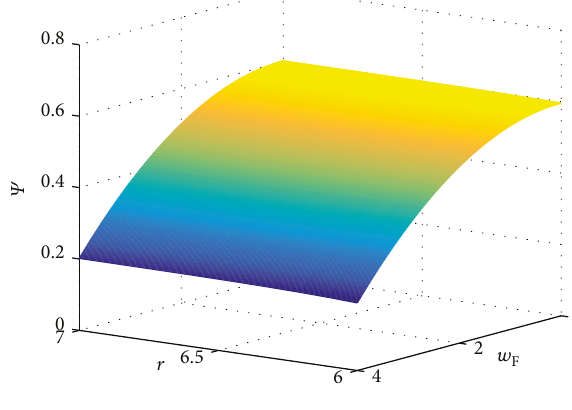
Figure 7: E ff ect of w